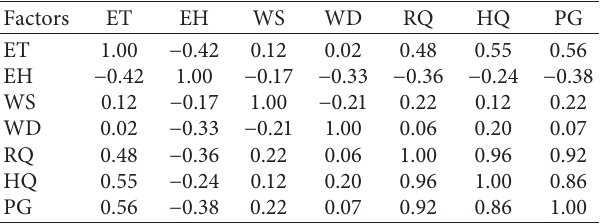
Table 1: Correlation coefficient between PV generation and other